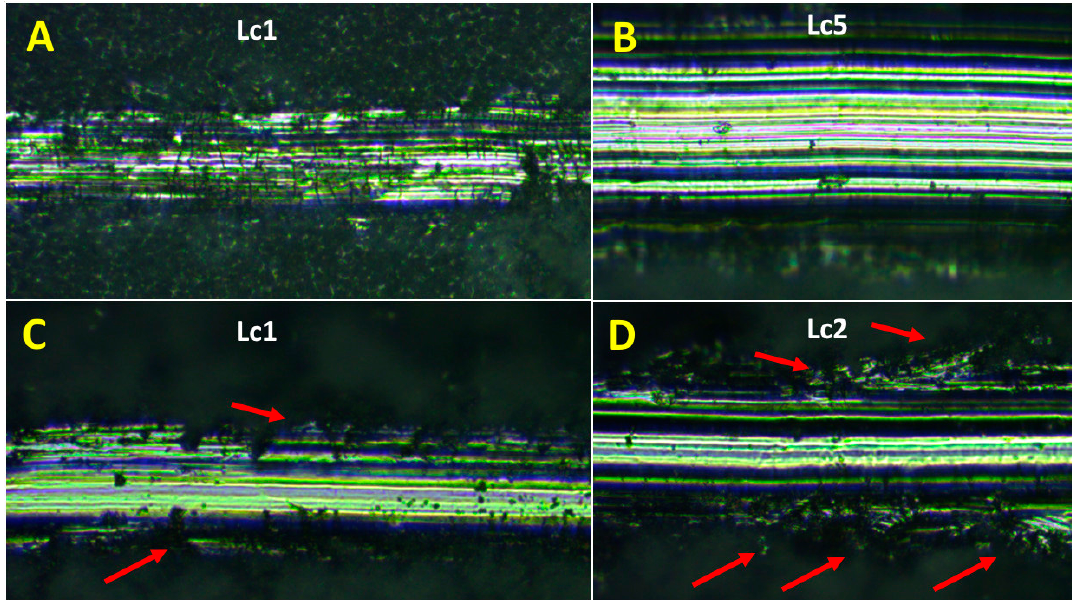
Figure 7. Optical micrographs of the ( A , B ) TAN-350 and ( C , D ) TAN-450 samples after the scratch testing. Figure7. Opticalmicrographsofthe( A , B )TAN-350and( C , D